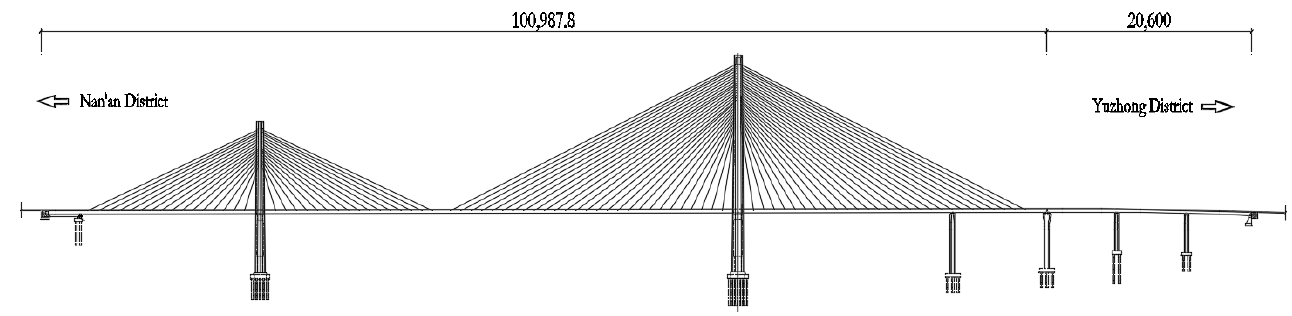
Figure 1. The bridge type layout of Nanjimen Yangtze River Track Special Bridge (unit: mm).